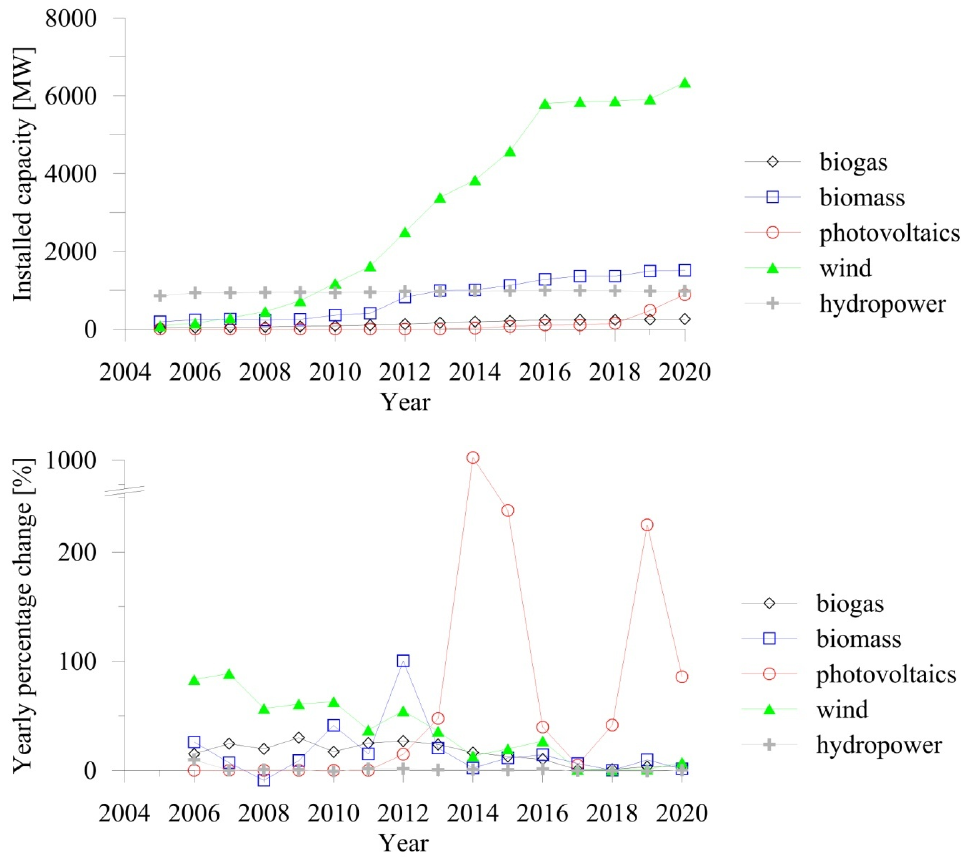
Figure 2. Dynamics of RES installations in Poland: installed capacity in MW from 2005 ( top ), yearly percentage change from 2006/2005 ( bottom ).